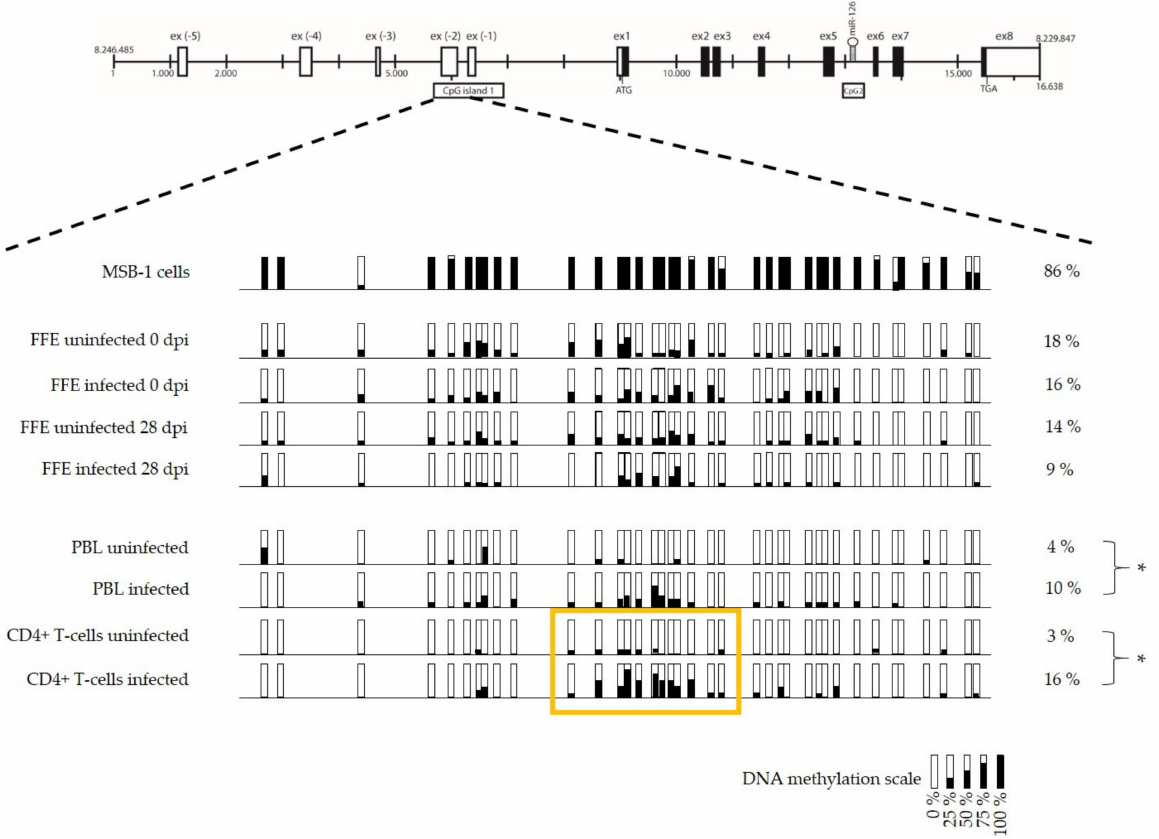
Figure 3. DNA methylation pattern of the CpG1 region in the MSB-1 cell line and in vivo samples from infected and uninfected birds. The horizontal line represents introns. The percentage of methylation is indicated by the black coloration inside the rectangles that represent each cytosine/guanine dinucleotide at a precise location. The yellow frame surrounds a region with a differential DNA methylation pattern. Two-way analysis of variance (ANOVA): *, p < 0.05 represent significant